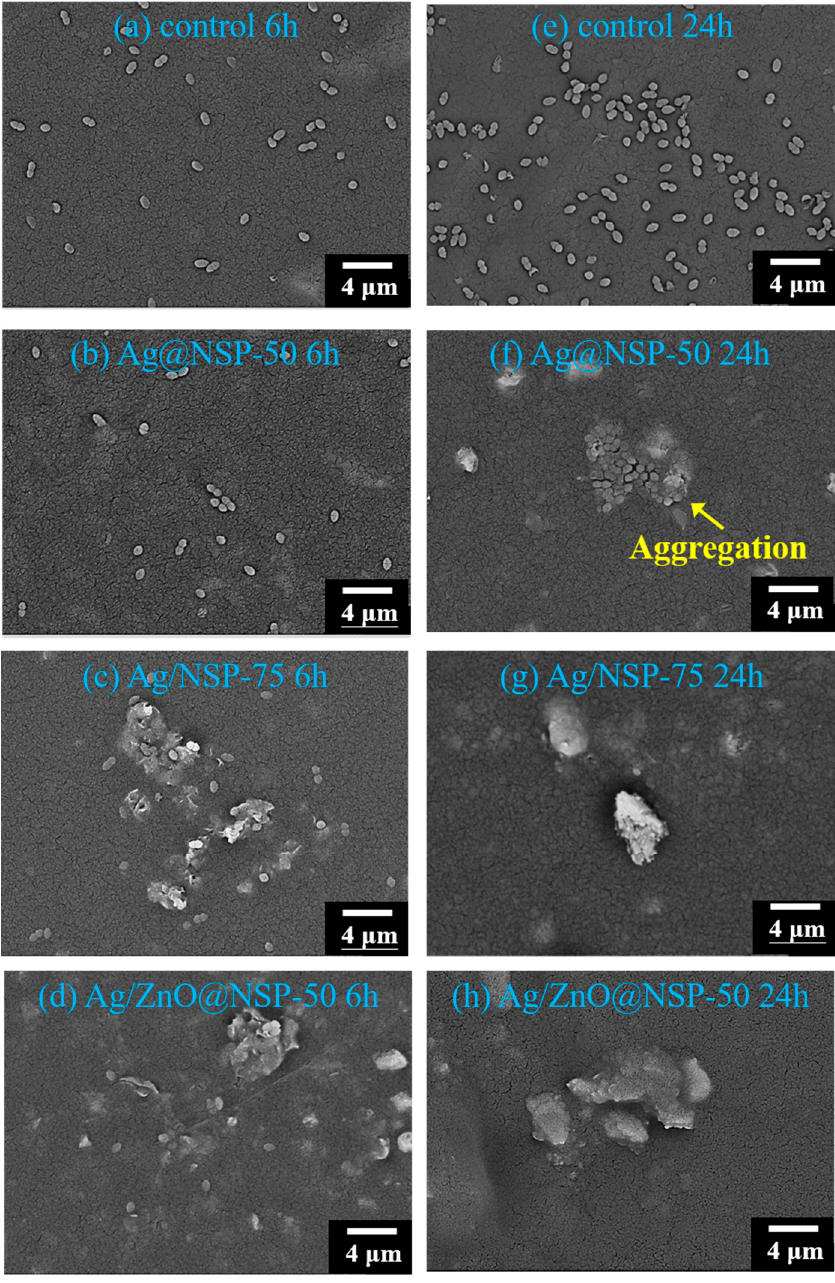
Figure 14. SEM images (2500x) of E. faecalis on the surfaces of UAC50/TPGDA = ( w/w = 70/30) with various antibacterial agents: control ( a , e ); 50 ppm Ag@NSP ( b , f ); 75 ppm Ag@NSP ( c , g ); 50 ppm Ag/ZnO@NSP ( d , h ) for 6 h and 24 h, respectively.